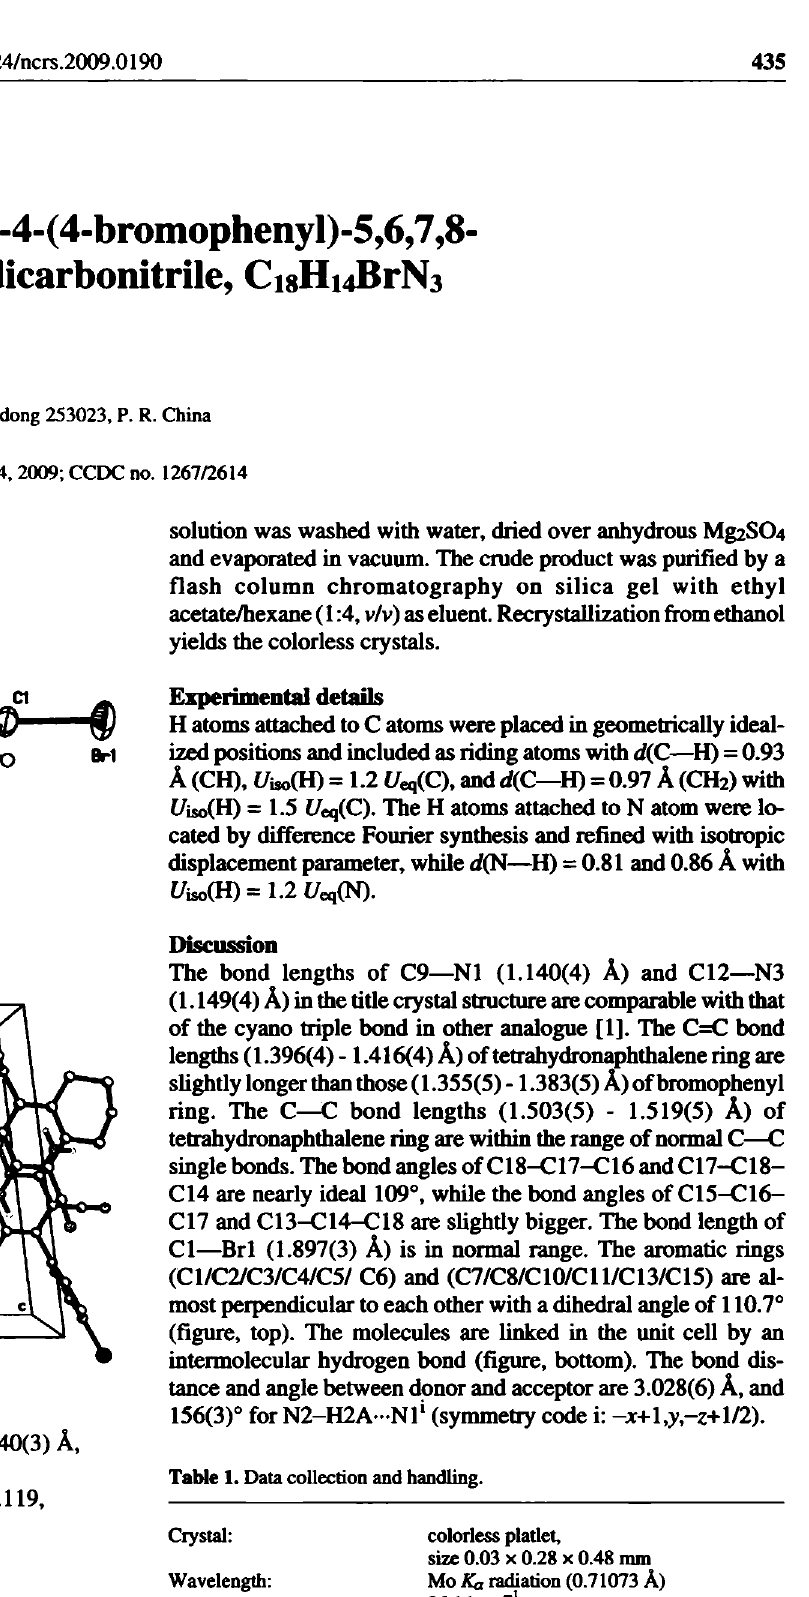
Table 1. Data collection and handling.